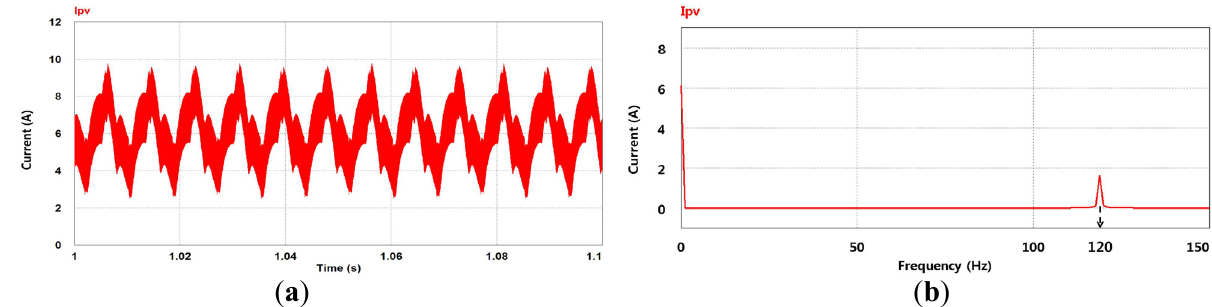
Figure 14. Simulation waveform of PV current without compensation. ( a ) Time domain; ( b ) frequency domain.